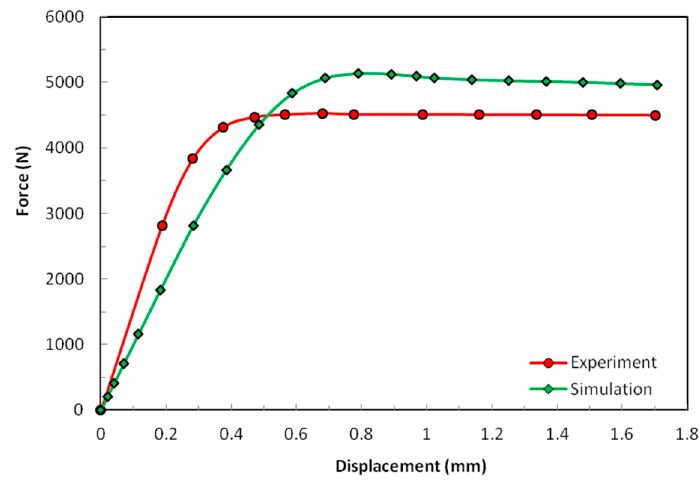
Figure 9. Shear results of the test and the simulation.